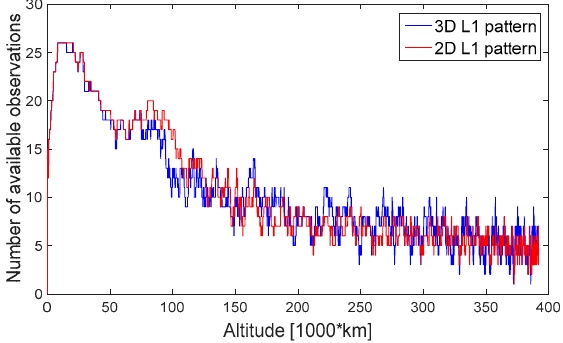
Table 2. Definition of representative portions. Figure 11. Number of available observations during the assumed MTO.